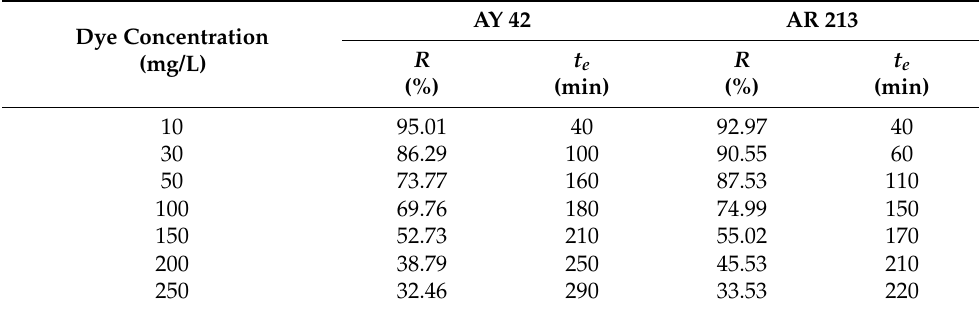
Table 6. Influence of the initial concentration of dye solutions on the adsorption capacity of PM4.